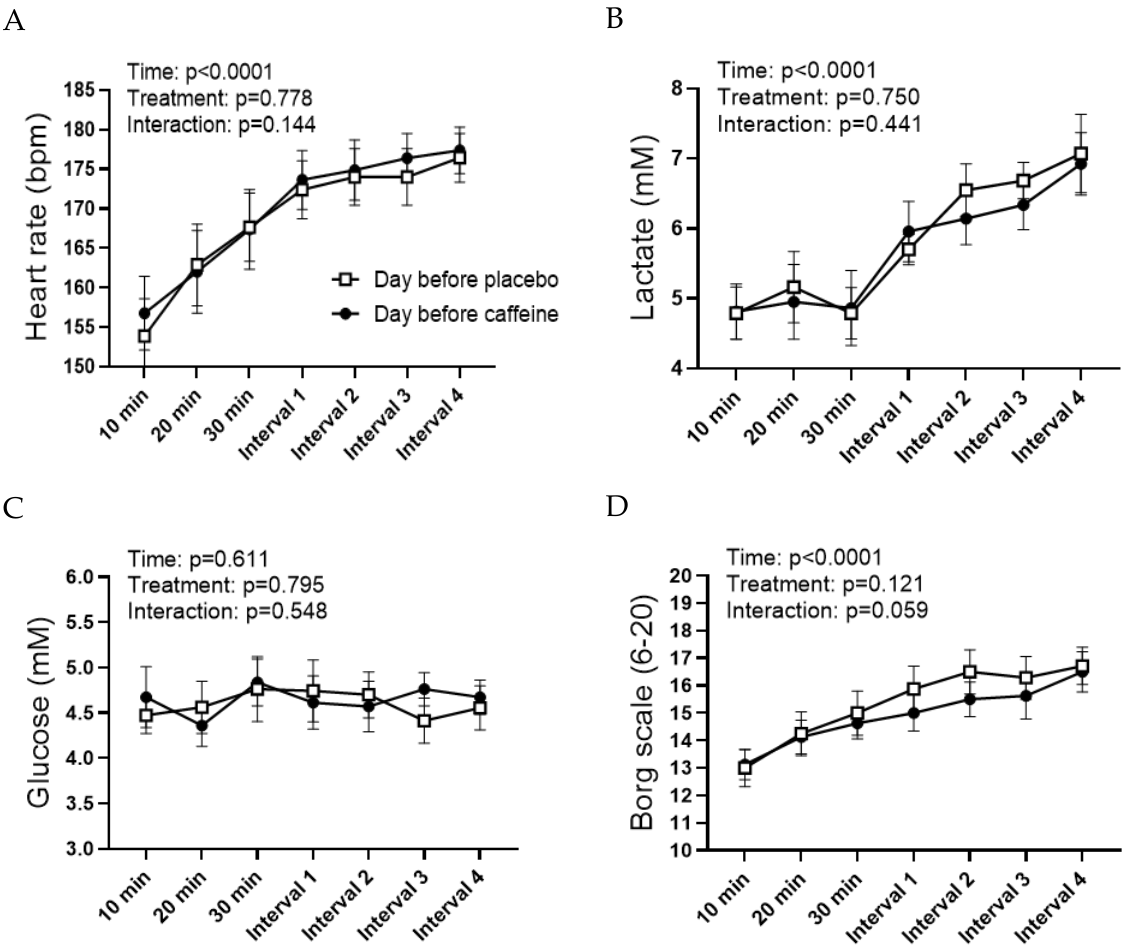
Figure 2. Metabolic responses to the exercise sessions. ( A ) Heart rate. ( B ) Capillary lactate. ( C ) Capillary glucose. ( D ) Perceived exertion according to the Borg scale. Data are mean ± SEM. N = 8 for all figures.